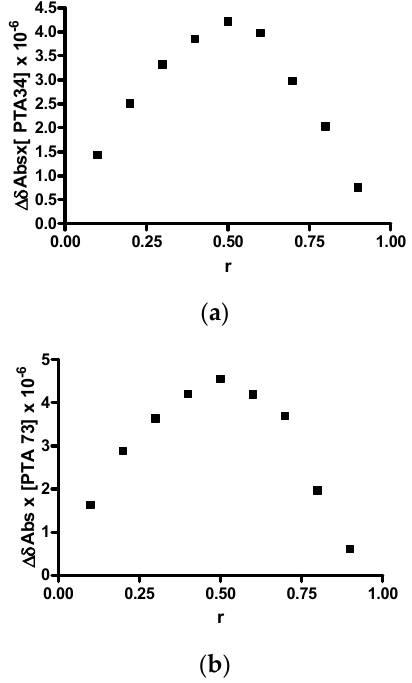
Figure 3. Job plots. ( a ) PTA 34/HP- β -CD; ( b ) PTA 73/HP- β -CD.